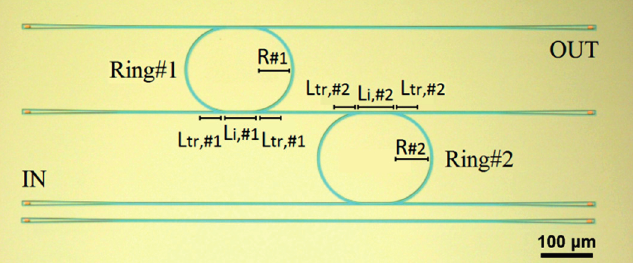
Figure 5. Optical image of a representative fabricated SOI Vernier